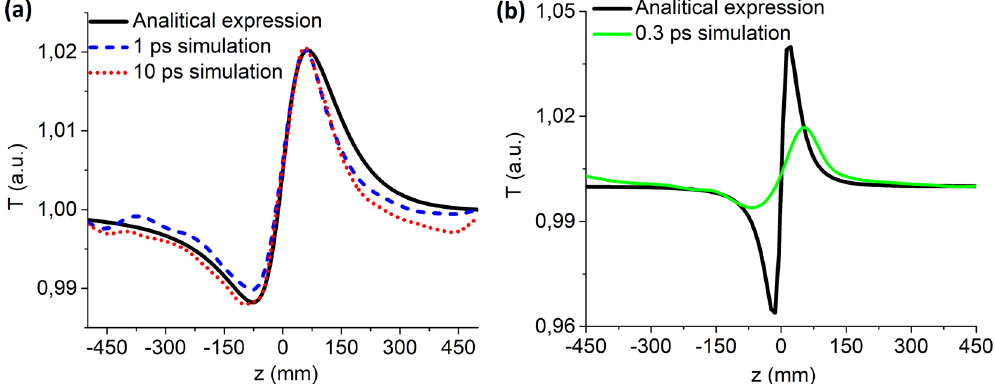
Figure 1. Z-scan curves (colored) obtained through the numerical simulation of the method (see Methods) for ( a ) 1 and 10 T 0 and ( b ) 0.3 T 0 pulses for the central wavelength λ 0 = 0.3 mm and crystal thickness of 0.3 mm; black curve corresponds to the analytical model for monochromatic THz